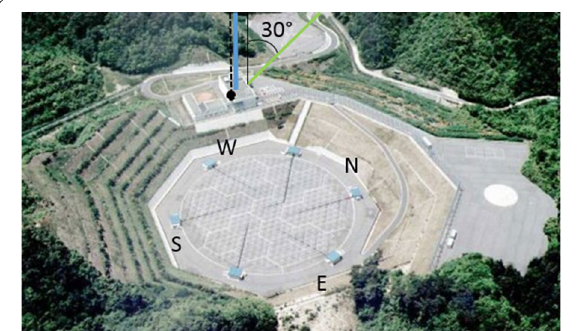
Fig. 1 Photograph of the Shigaraki MU Observatory. The black dot and the vertical dashed line show the location and upward-looking direction of the fish-eye camera, respectively. The blue line shows the vertically pointing beam of the RRM lidar. The green line shows the MPL beam steered 30° off zenith toward